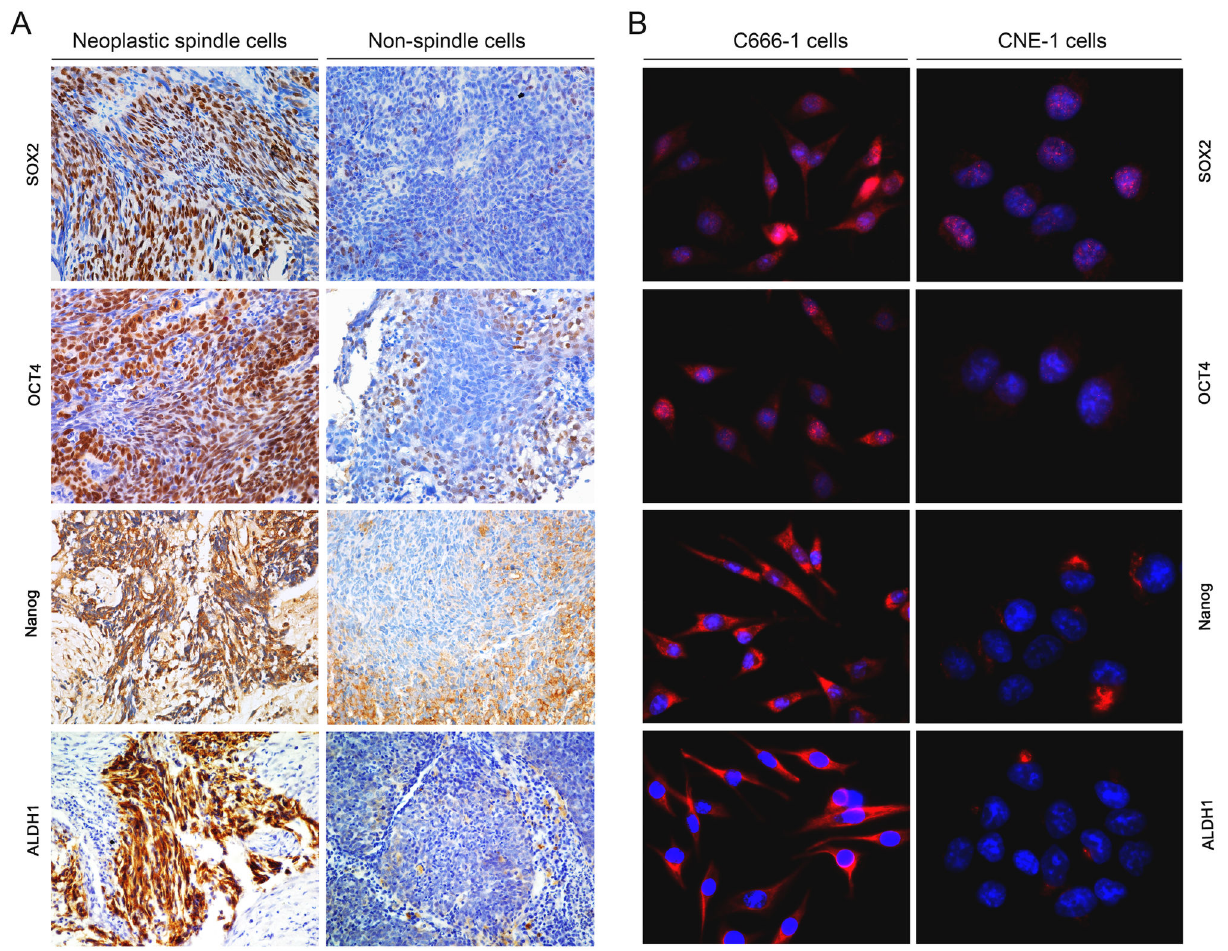
Figure 2. Neoplastic spindle cells exhibit properties of stem cells. (A) Stem cells-like markers SOX2, OCT4, Nanog and ALDH1 were markedly expressed in neoplastic spindle cells compared with neoplastic non-spindle cells (DNKC) in NPC. (B) Different expression levels of SOX2, OCT4, Nanog and ALDH1 proteins in human NPC C666-1 (undifferentiated, spindle-like morphology) and CNE1 (well differentiated, epithelial-like morphology) cell lines detected by immunofluorescence analysis. doi: